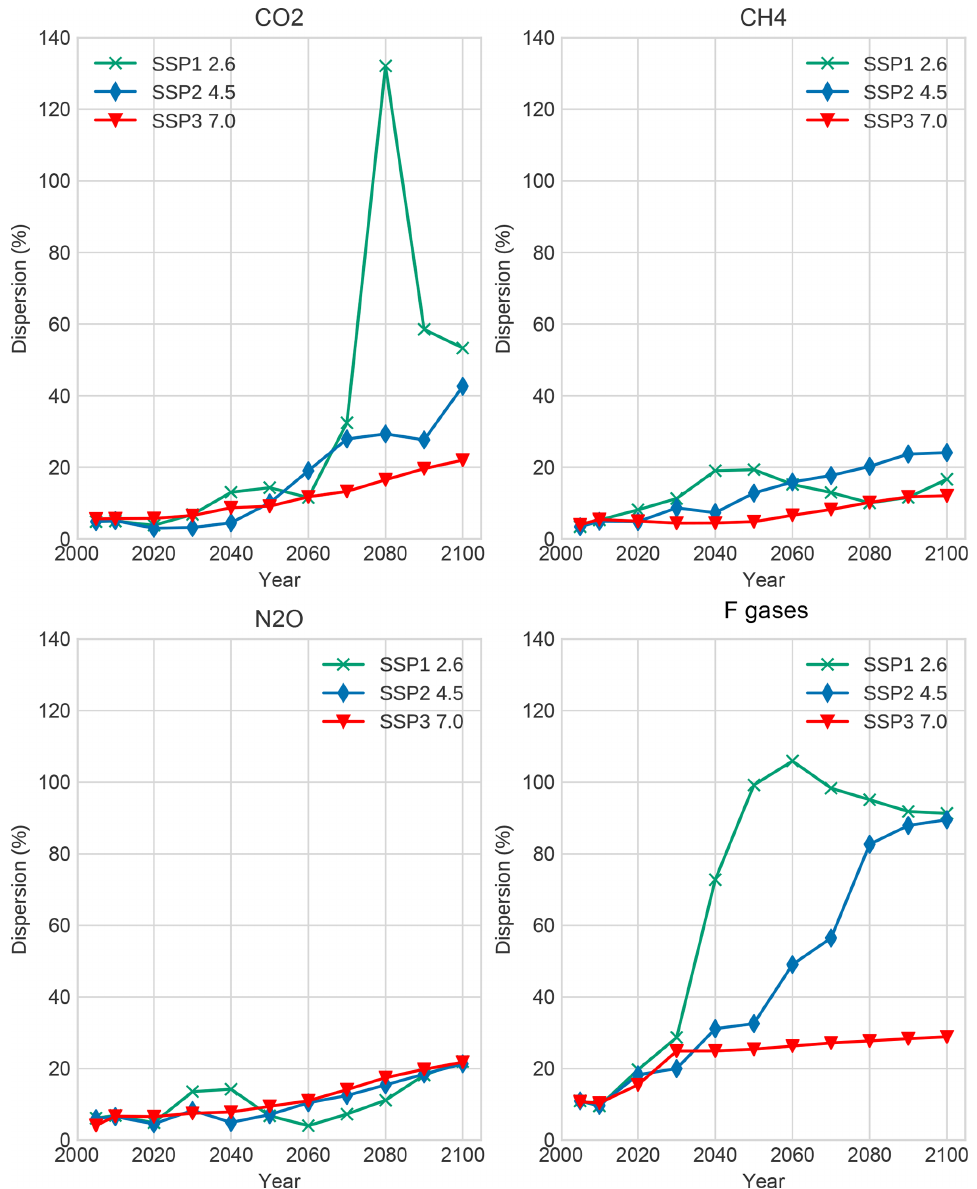
Figure H1. Dispersion analysis results for GHGs with aggregated F